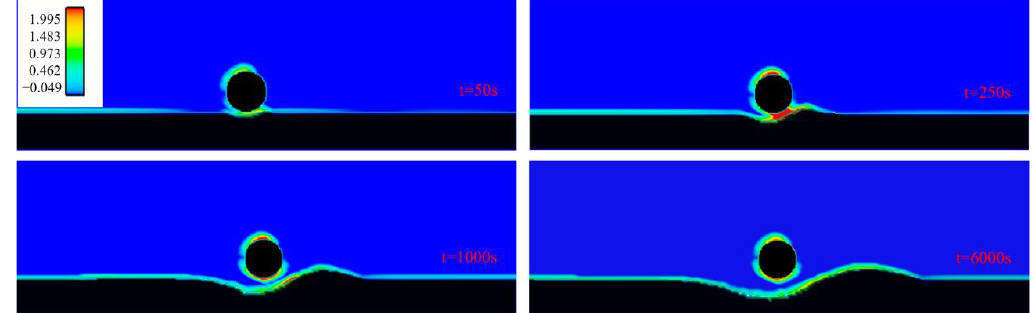
Figure 6. The shear stress excess change in scour processes.